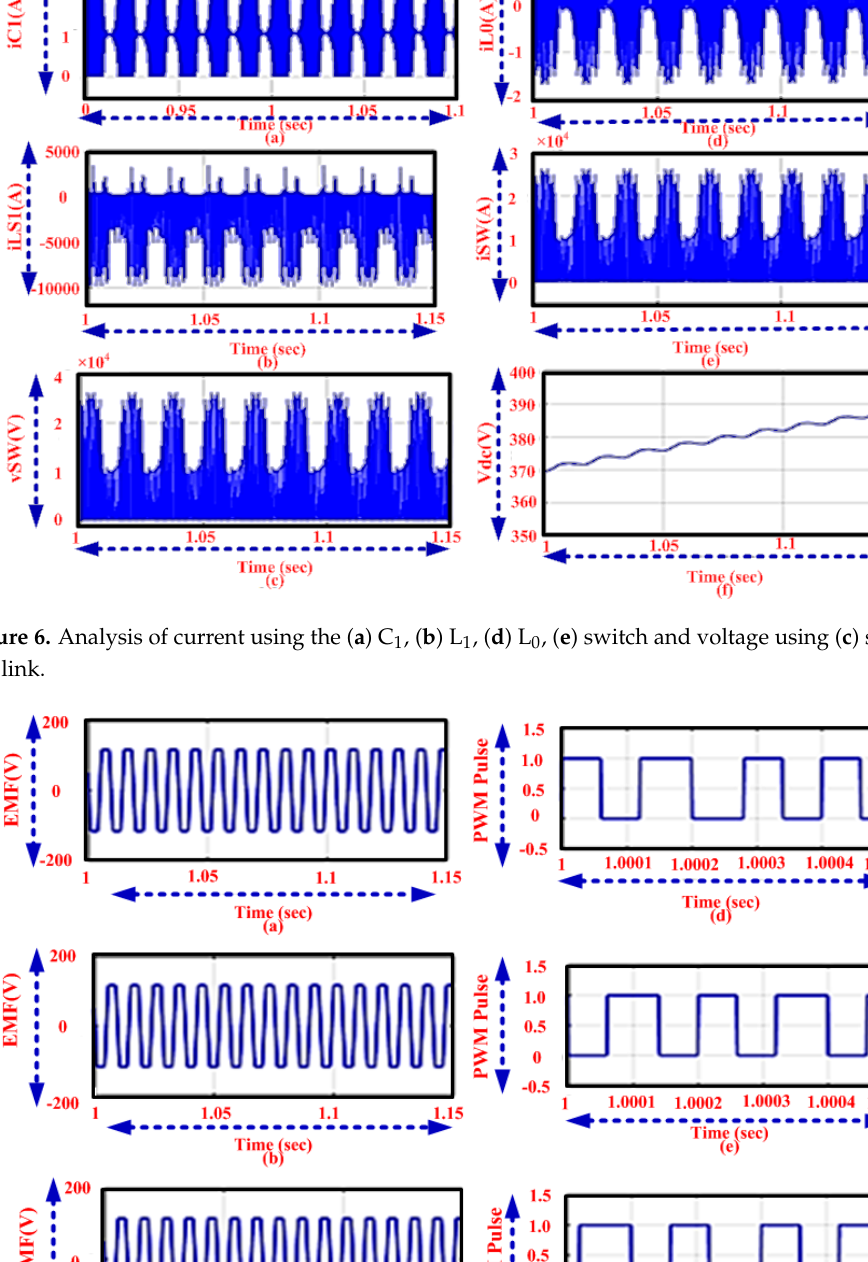
12 of 20 Figure 5. Analysis of Speed using the ( a ) proposed ( b ) moth-flame optimization (MFO) method and ( c ) proportional integral (PI) controller and Torque using the ( d ) proposed ( e ) MFO method and ( f ) PI controller. Figure 6 shows the analysis of capacitor and inductor, current, and voltage using the proposed method. Figure 6a–c shows the behavior of proposed drives used inductor and capacitor components for correction of the power factor which resulted in improvement of power quality and can be achieved by the complete range of speed control. Figure 6d,e shows the different operations of the switch with optimal voltage/current. By increasing time, DC-link voltage is increases and reached maximum of 387 V, thereby corrected the power it can be seen in Figure 6f. The output performance analysis of EMF and PWM with proposed and existing methodologies is described in Figure 7. In the figure, the output performance of the BLDC motor, the proposed